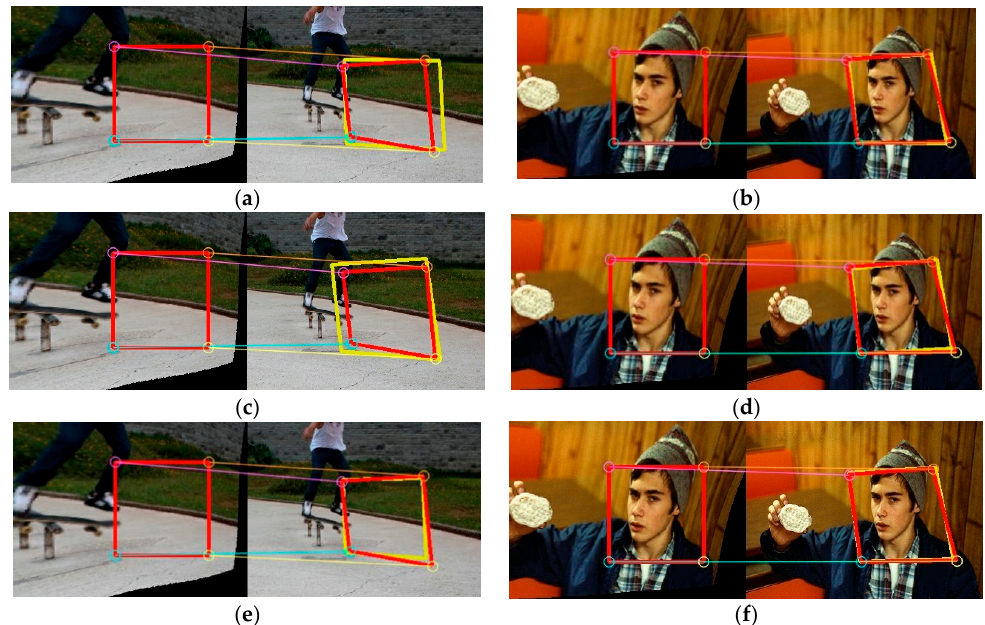
Figure 7. Visualization analysis of the proposed algorithm under different CNNs (The red boxes indicate the ground truth, and the yellow boxes are the estimation results): ( a ) accuracy of image registration under VGG (RMSE = 10.154711); ( b ) accuracy of image registration under VGG (RMSE = 2.240815); ( c ) accuracy of image registration under Googlenet (RMSE = 7.2284245); ( d ) accuracy of image registration under Googlenet (RMSE = 1.9681364); ( e ) accuracy of image registration under Xception (RMSE = 3.1798978); ( f ) accuracy of image registration under Xception (RMSE = 1.4085304).